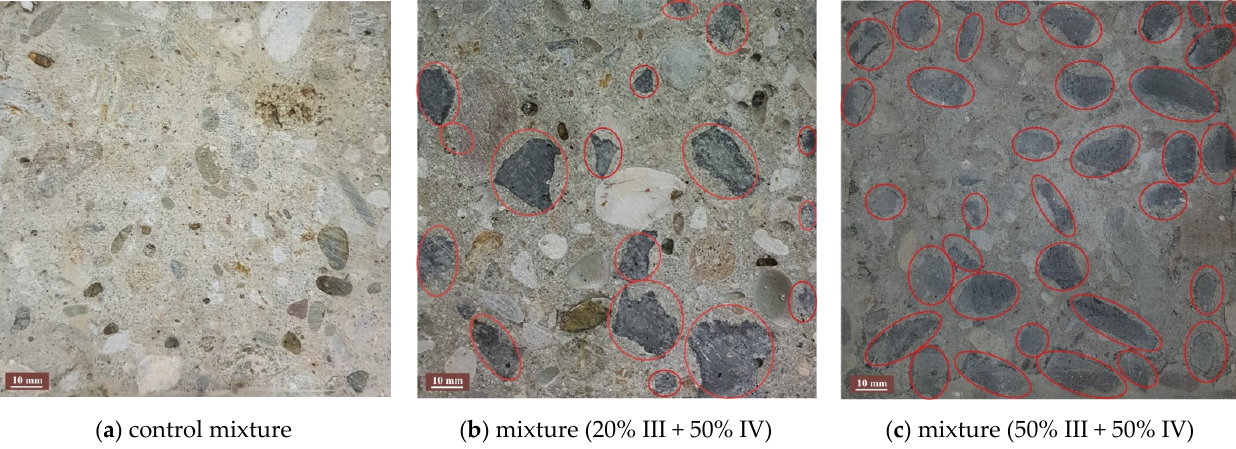
Figure 9. Concrete surface degradation after 28 cycles of freeze-thaw and salt exposure. Explanation: ( a ) visual examination of Control concrete mixture degradation; ( b ) visual examination of 20% III + 50% IV mixture degradation; ( c ) visual examination of 50% III + 50% IV mixture degradation. The positions of copper slag aggregate grains are highlighted by red circles.